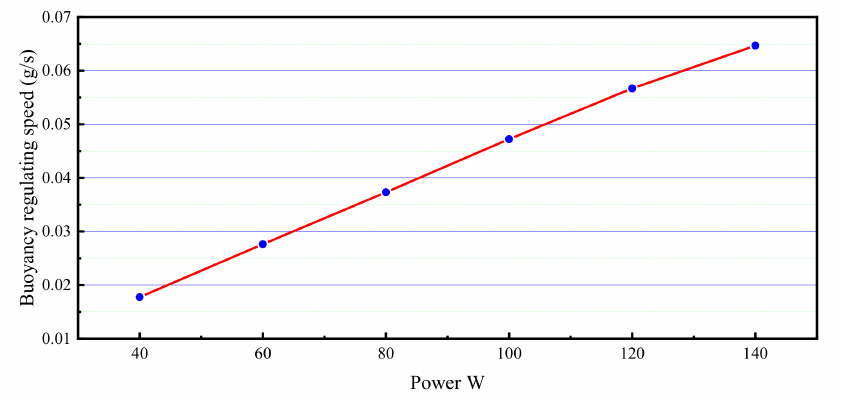
Figure 13. The buoyancy regulation speed of BCM under di ff erent driving power.